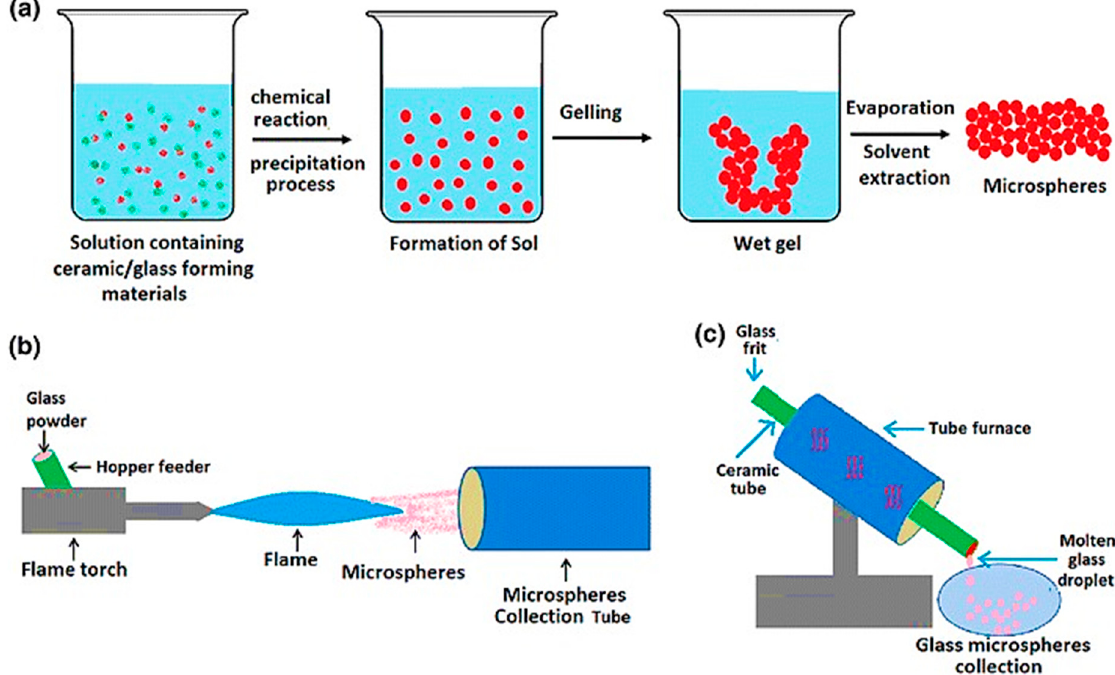
Figure 6. Illustration of glass microsphere production by the ( a ) sol-gel, ( b ) flame spheroidization, and ( c ) furnace methods. Figure retrieved from (Hossain et al. 2015) [49].